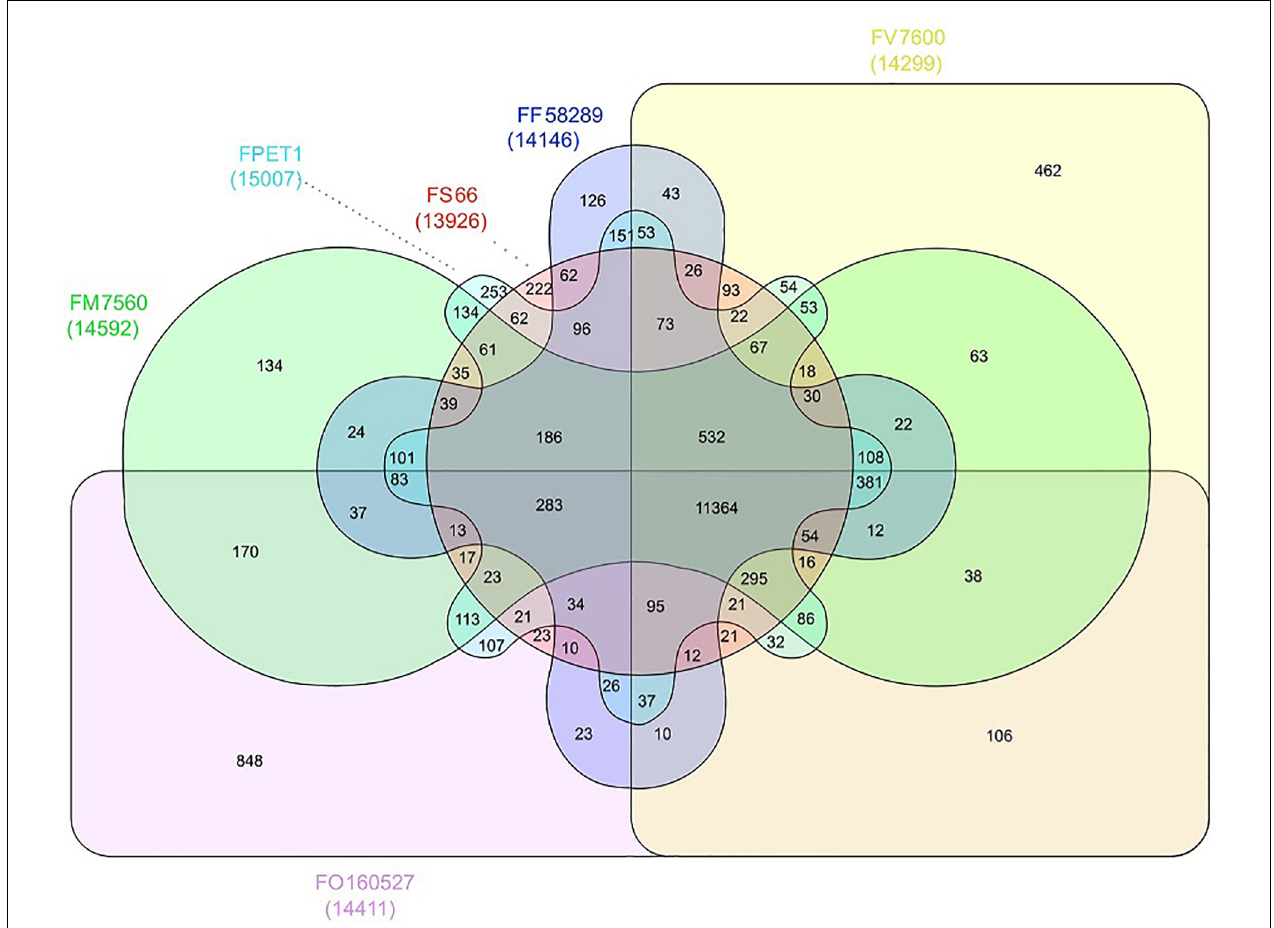
FIGURE 5 | Orthogroup sharing relationships among six Fusarium genomes. The first two characters in the isolate names denote the species and the rest characters were the strain names listed in Supplementary Table 1 . For some isolates, alphabet characters such as ‘NRRL’ were omitted for convenience. FM, F. mangiferae ; FP, F. proliferatum ; FF, F. fujikuroi ; FV, F. verticillioides ; FO, F. oxysporum